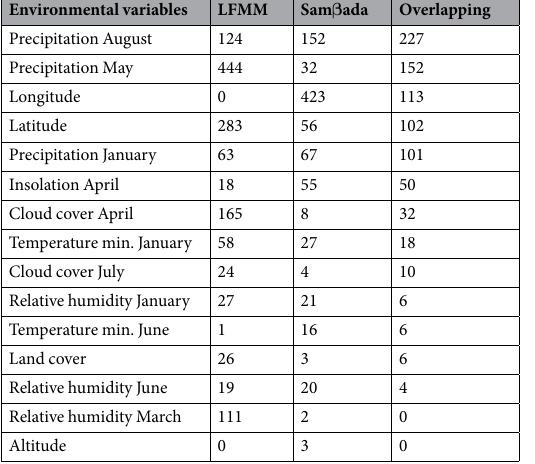
Table 1. Environmental variables and number of associated SNPs identified exclusively by LFMM or Sam β ada and simultaneously by both